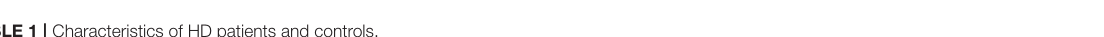
TABLE 1 | Characteristics of HD patients and controls.